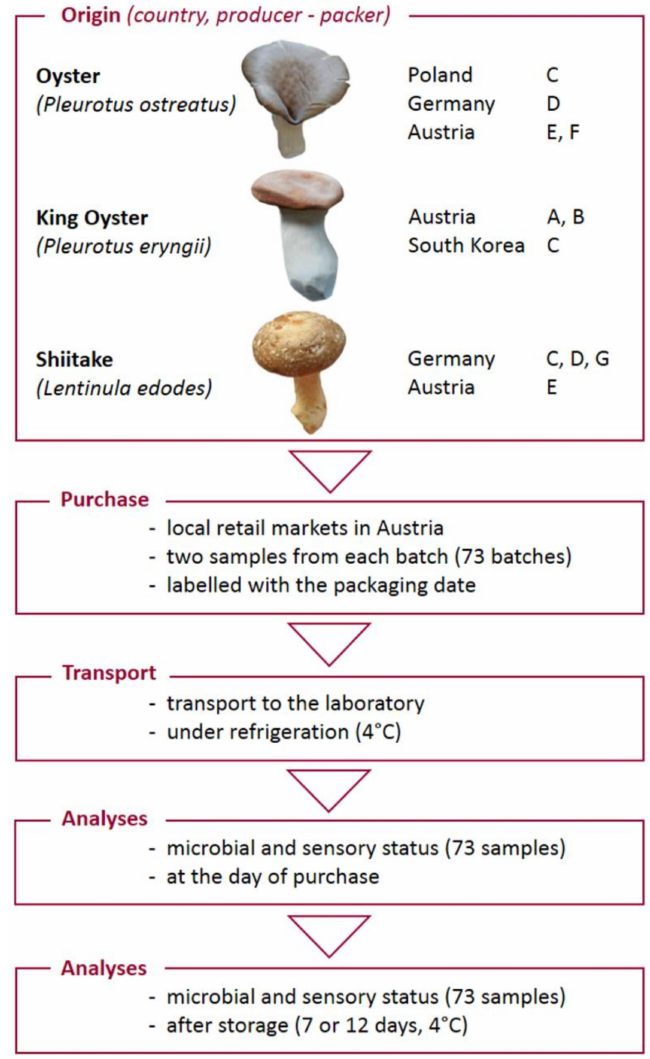
Figure 1. Schematic overview of the experimental